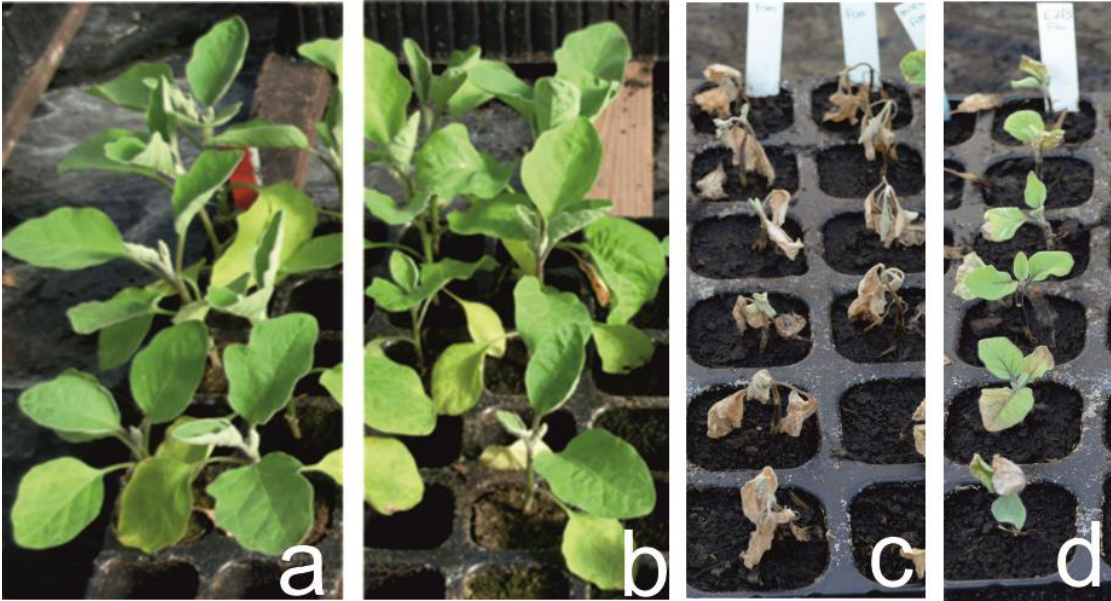
Figure 2. Plantlets of line ‘305E40’ ( a ), of the F 1 hybrid ( b ), of two full sensitive lines ‘DR2’ and ‘Tal1/1’ ( c ) and of ‘67/3’ ( d ) at 30 DAI after inoculation with F. oxysporum . Table 2. Disease score of the parental lines, of the two control lines for complete susceptibility (‘Tal1/1’) and resistance ( S. aethiopicum ), the F 1 hybrid (‘67/3’x‘305E40’) and the mean value in the RIL populations. Skewness, kurtosis, broad sense heritability and transgressive genotypes for the trait in study with respect to both parental lines are also reported.